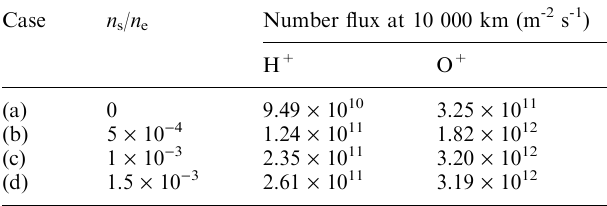
Table 4. A list of the density ratio n the ion number fluxes for the four cases, whose boundary conditions are shown in Table 3